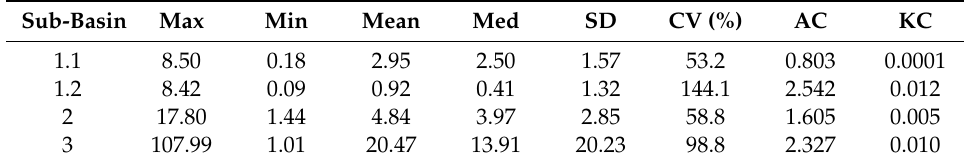
Table 1. Descriptive statistics of discharge (L / s) of sub-basins, from 2012 to 2016.